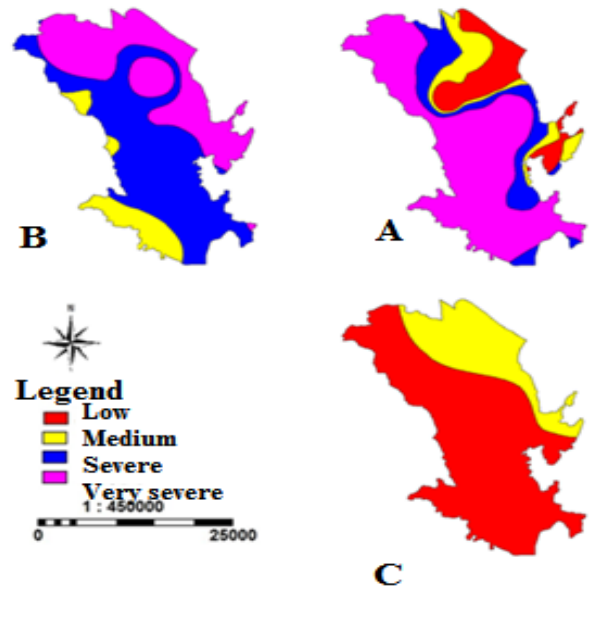
Figure 2. Desertification class of water indicators (A: groundwater drop, B: EC, C: